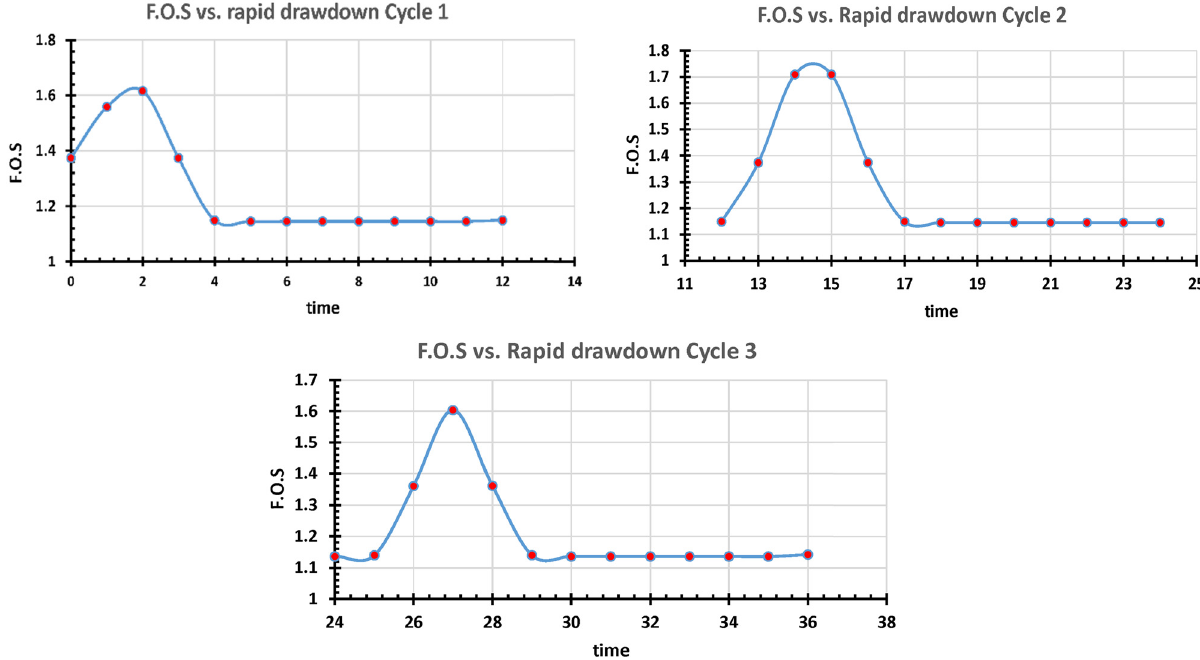
Figure 14: E ff ect of rationing system on the